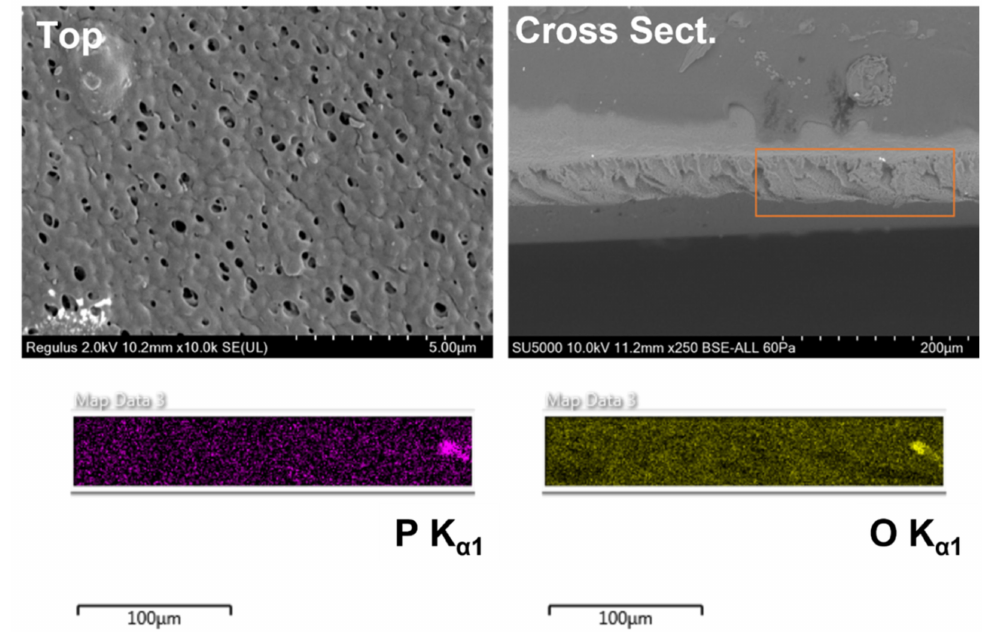
Figure 7. SEM-EDS images of 10% PVDF- g -EGMP membranes cast with 2 wt% glycerol. Phosphorus (purple) and oxygen (yellow) distributions are shown for the region highlighted in the cross-sectional image. Average pore diameter was measured to be 0.338 ± 0.066 µ